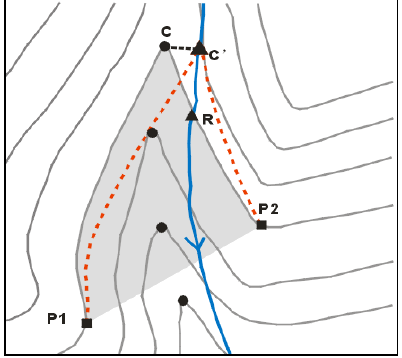
Figure 8. The displacement of contour to match river